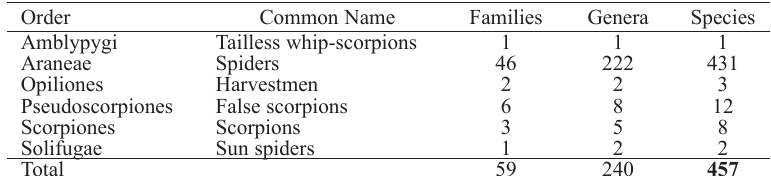
Table 1 Order composition of the non-acarine arachnids in the Ndumo Game Reserve,